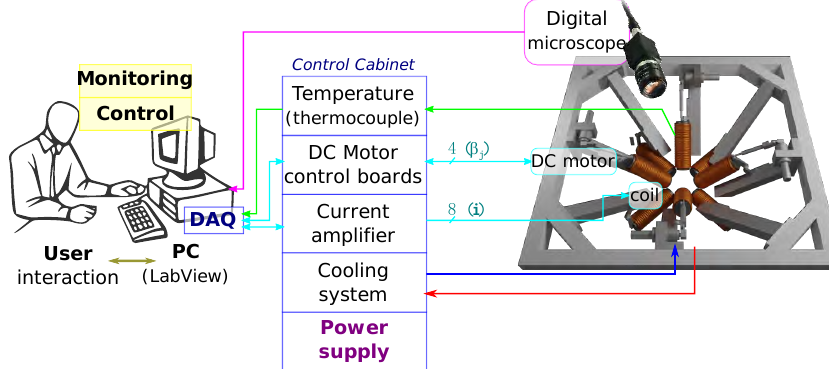
Figure 15. Synoptic of OctoRob platform architecture.